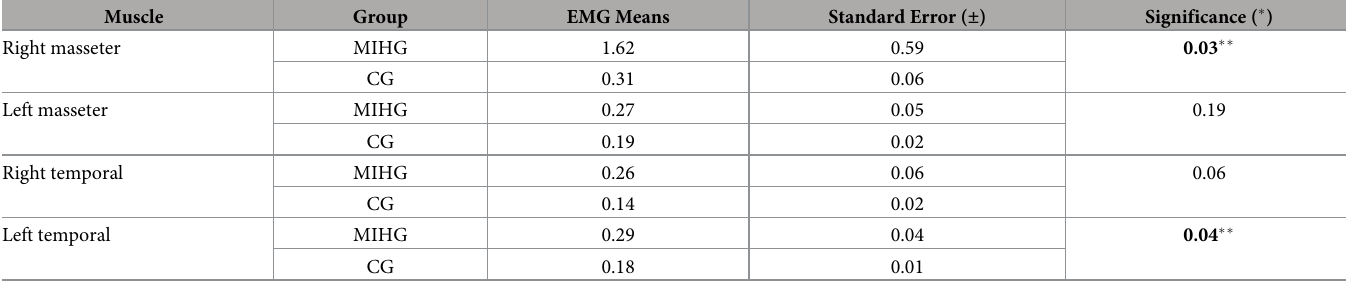
Table 6. Mean values, standard error, and statistical significance (p � 0.05) of the normalized electromyographic data in the left laterality condition, for each mus- cle evaluated, in the MIH group (MIHG) and control group (CG). Muscle